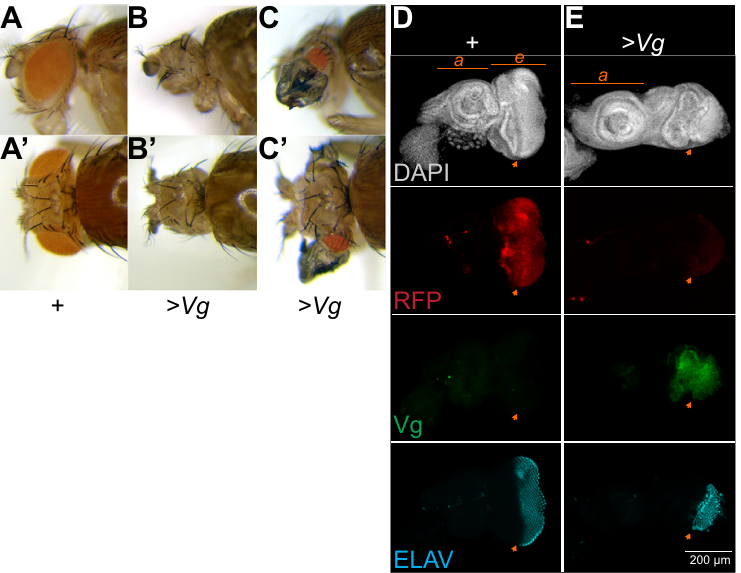
Fig 1. Vg expression transforms the eye into wing tissue. (A-C) Side and dorsal views of the head and eyes of wildtype eyGAL/CyO adults ( A ) and eyGAL > Vg adults ( B,C ). About half of all adults with > Vg production display pigmented wing-like projections, while the rest lack eyes entirely. (D,E) Eye-antennal imaginal discs from wildtype eyGAL > RFP larvae (D) and from eyGAL > RFP > Vg larvae (E) . Discs were immunostained for the Vg protein and for ELAV, a marker of differentiating photoreceptors. The antennal (a) and eye (e) portions of the disc are indicated, and the morphogenetic furrow that separates mitotically active undifferentiated cells in the anterior of the eye from differentiating photoreceptors in the posterior is marked with an orange arrowhead. The eye portions of discs with Vg production are distorted, with detectable Vg, low RFP signal, and very few differentiating photoreceptors at the posterior edge.